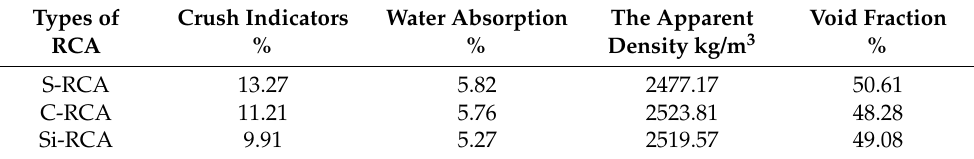
Table 3. Basic performance index of modified Recycled Coarse Aggregates (RCA.)